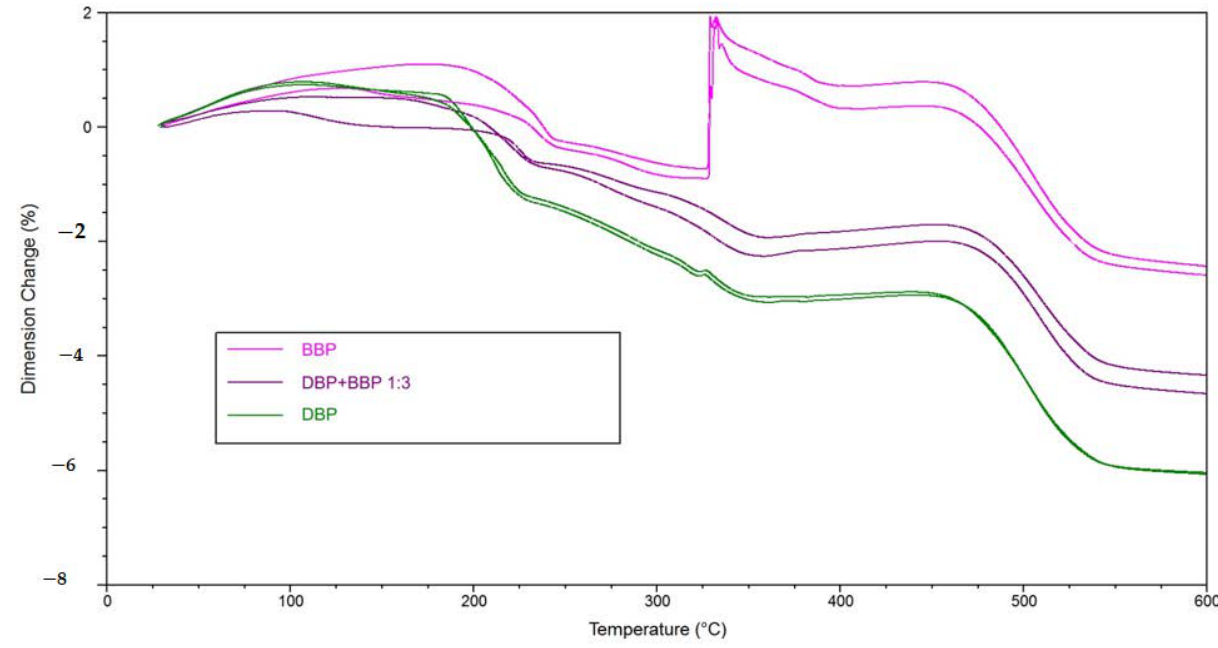
Figure 16. Direct comparison of the thermomechanical measurements (two each) of green bodies, produced by LCM with BBP, DBP, and 3:1-mixture of both,